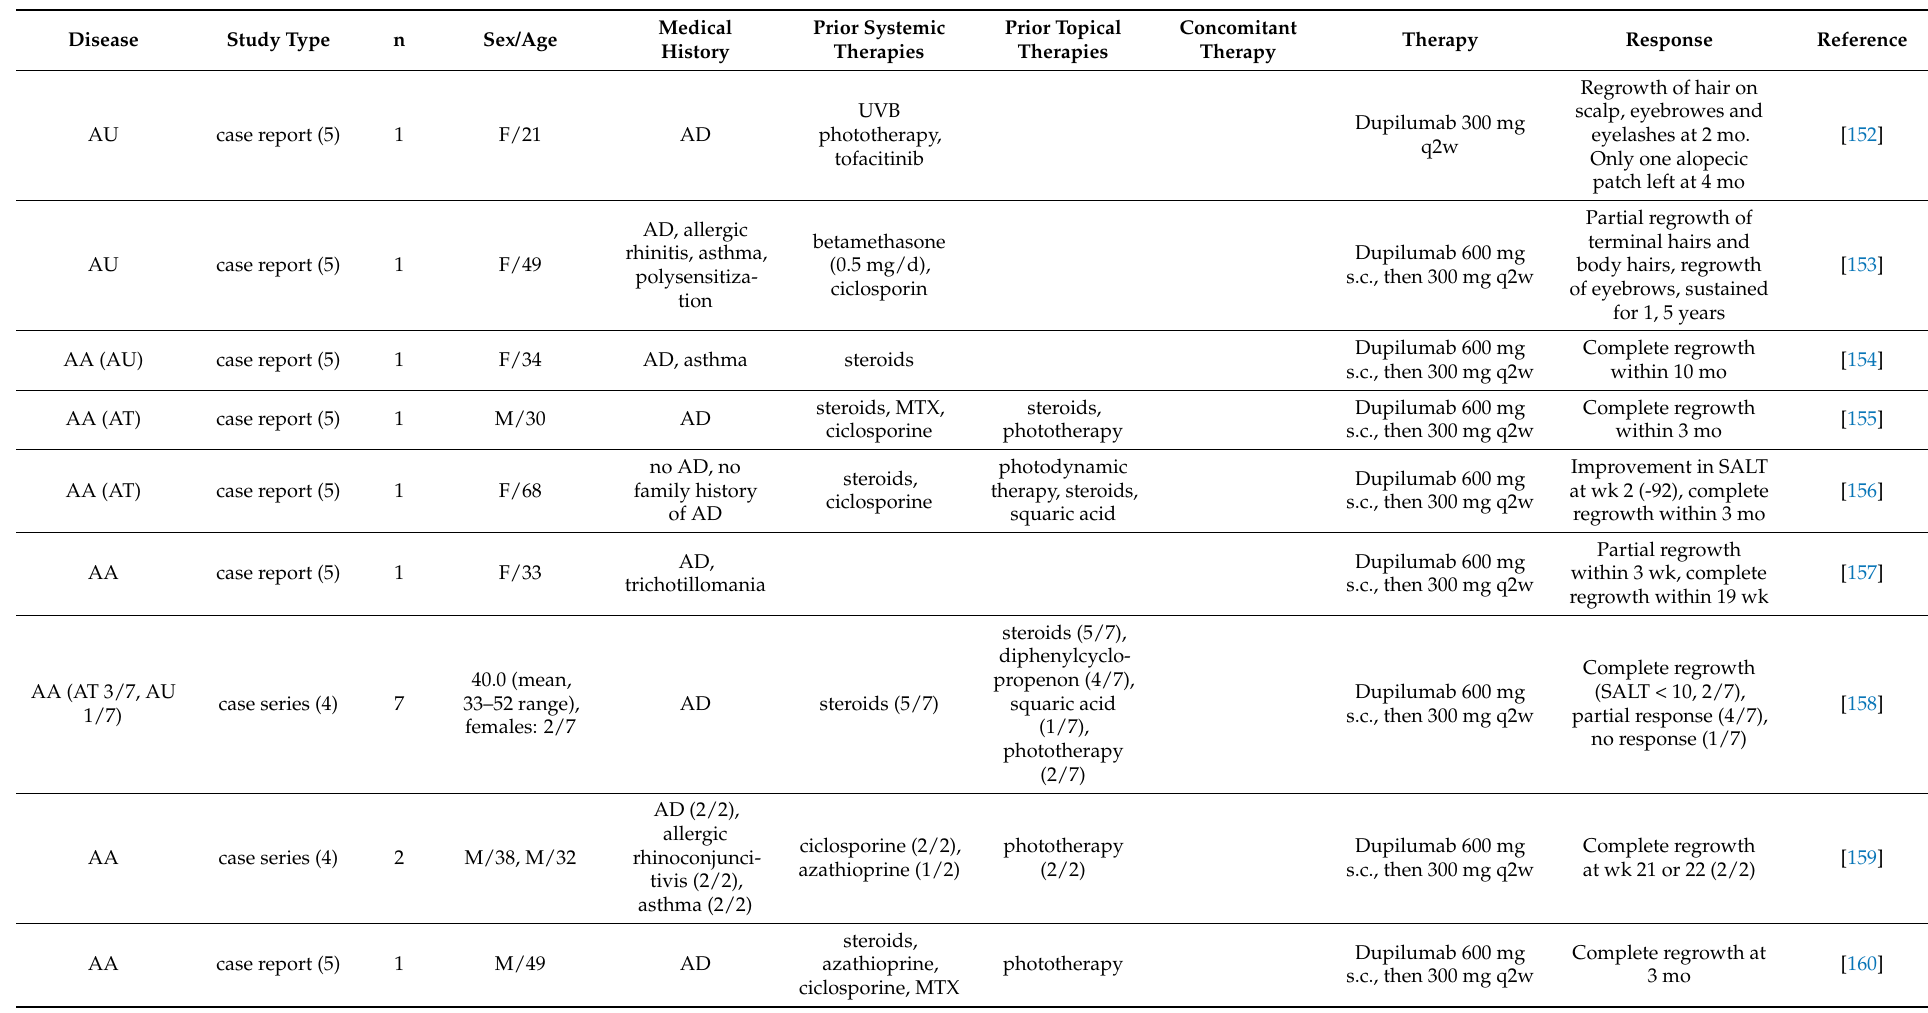
Table 4. Alopecia